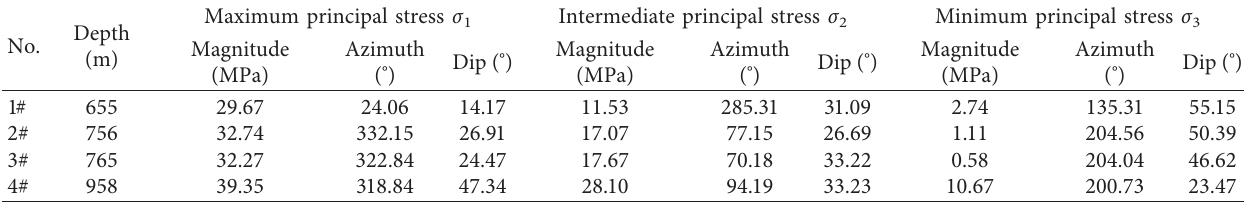
Table 3: In situ stress results of the stress relief method.